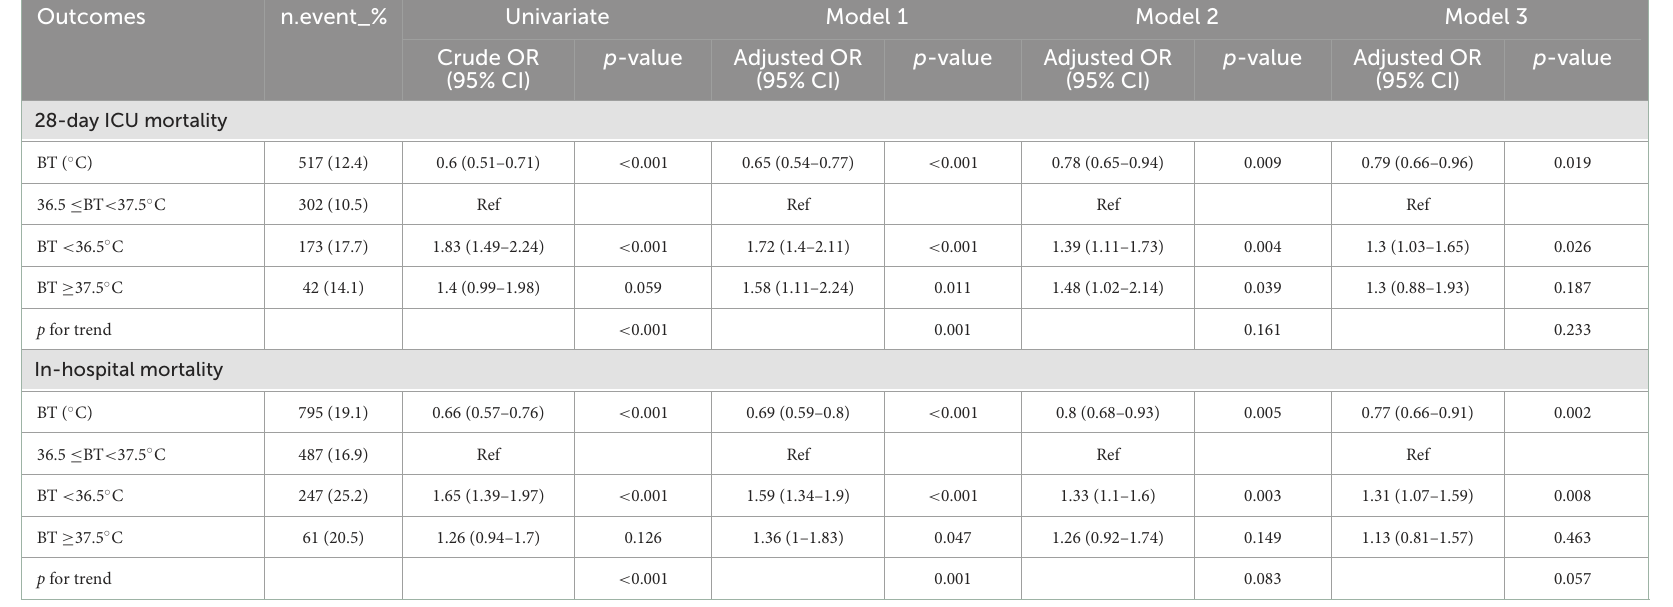
Data presented are ORs and 95% CIs. BT, body temperature. Model 1 adjusted for gender,age, marital status, and ethnicity; model 2 adjusted for model 1 + weight, WBC, albumin, BUN, creatinine,INR, PTT, anion gap, bicarbonate,calcium, chloride, andsodium;model3adjustedformodel2 +